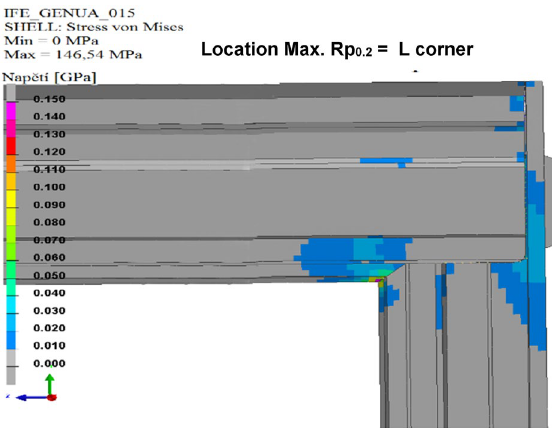
Figure 13. FEM stress map (colour contour) variant no. 6.